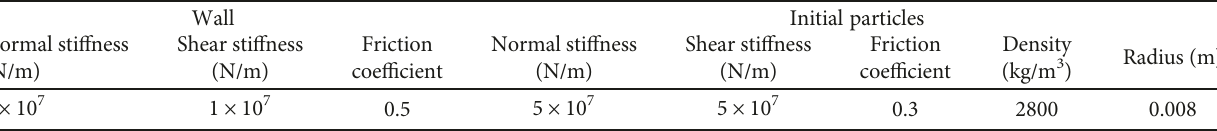
Table 1: Mesomechanical parameters of the walls and initial particles.